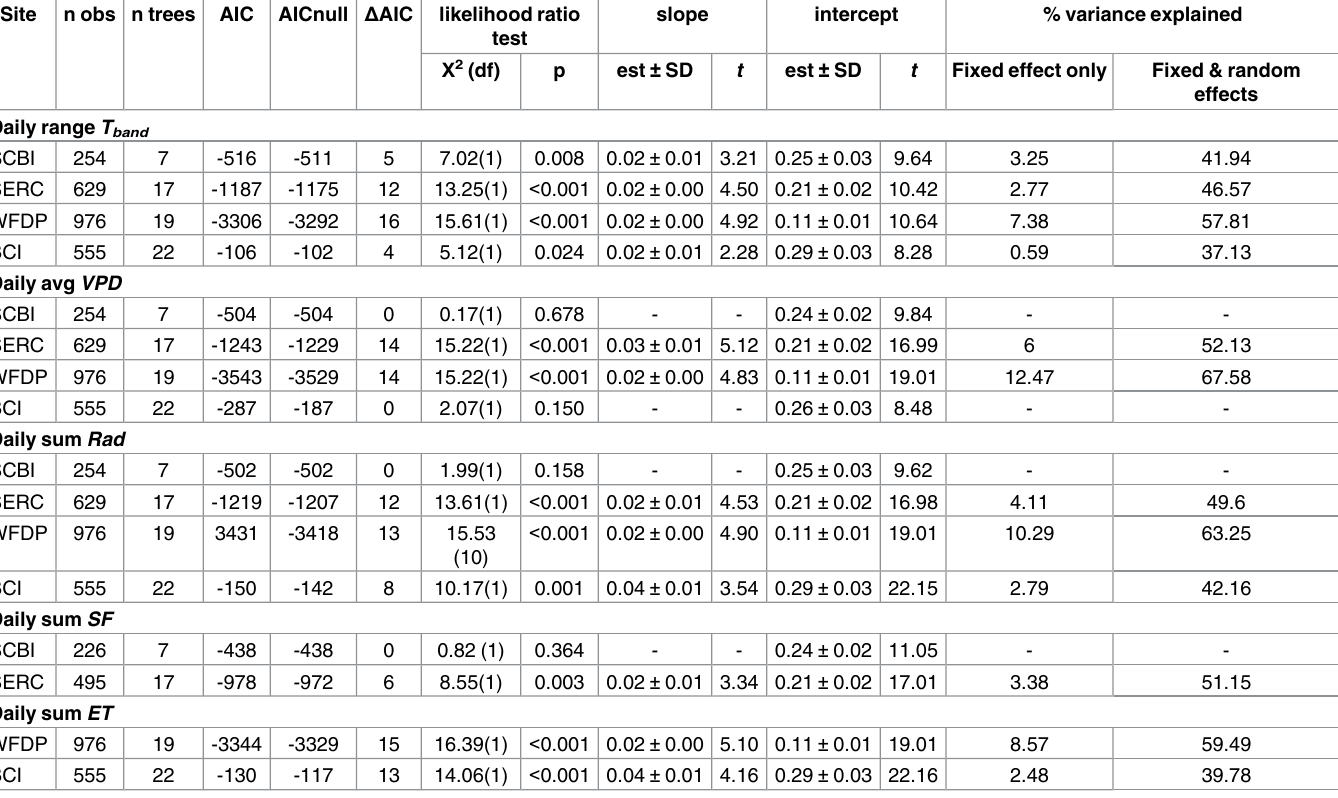
Fixed & random effects